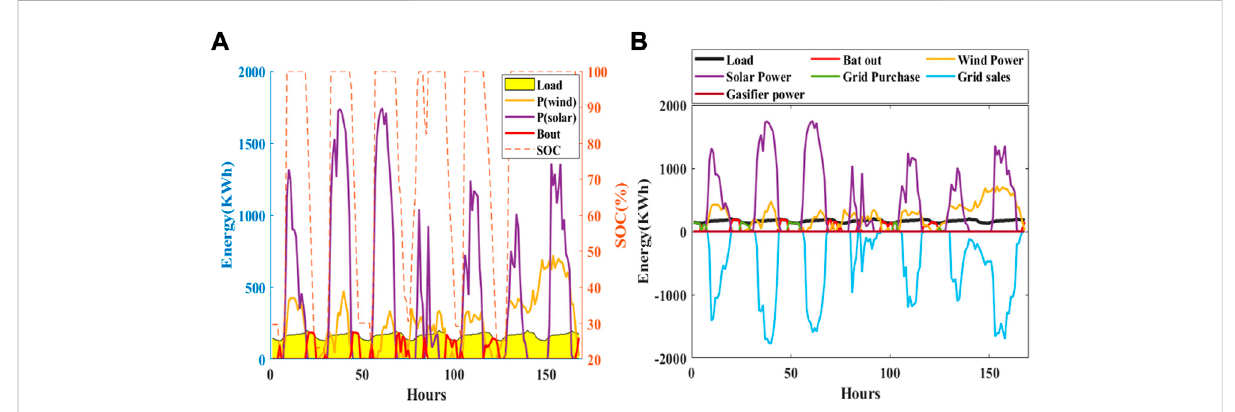
FIGURE 9 The power exchange between the adopted sources and batteries in (A) and with grid in (B) .